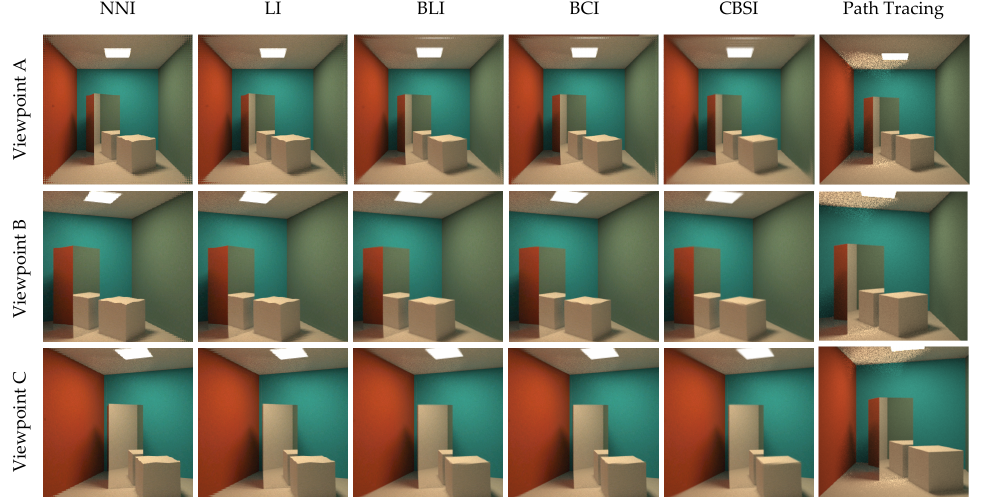
Figure 9. The comparison of novel views rendered by different methods (each column) at different viewpoints A, B and C (each